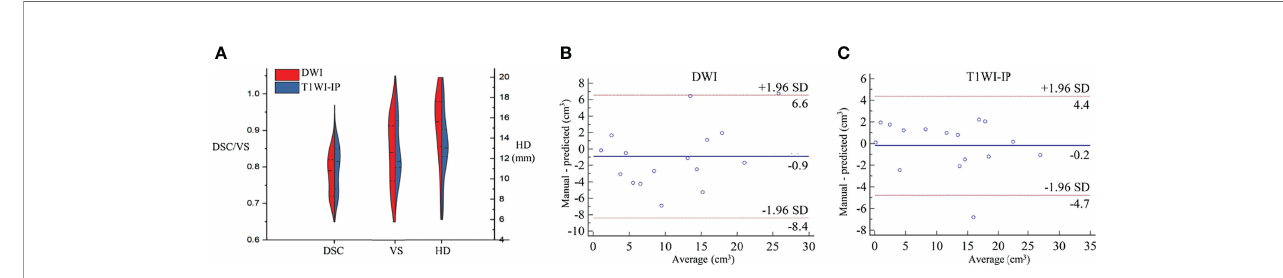
FIGURE 4 | The segmentation accuracy of bone metastases in the testing set. (A) Split violin plot of DSC, VS, and HD of the bone metastases on DWI and T1WI-IP images. (B) The Bland – Altman plot of the volume difference between manual annotation and model prediction on DWI images. (C) The Bland – Altman plot of the volume difference between manual annotation and model prediction on T1WI-IP images. DSC, Dice similarity coef fi cient; HD, Hausdorff distance; T1WI-IP, T1W images obtained using the Dixon technique with in-phase; VS,